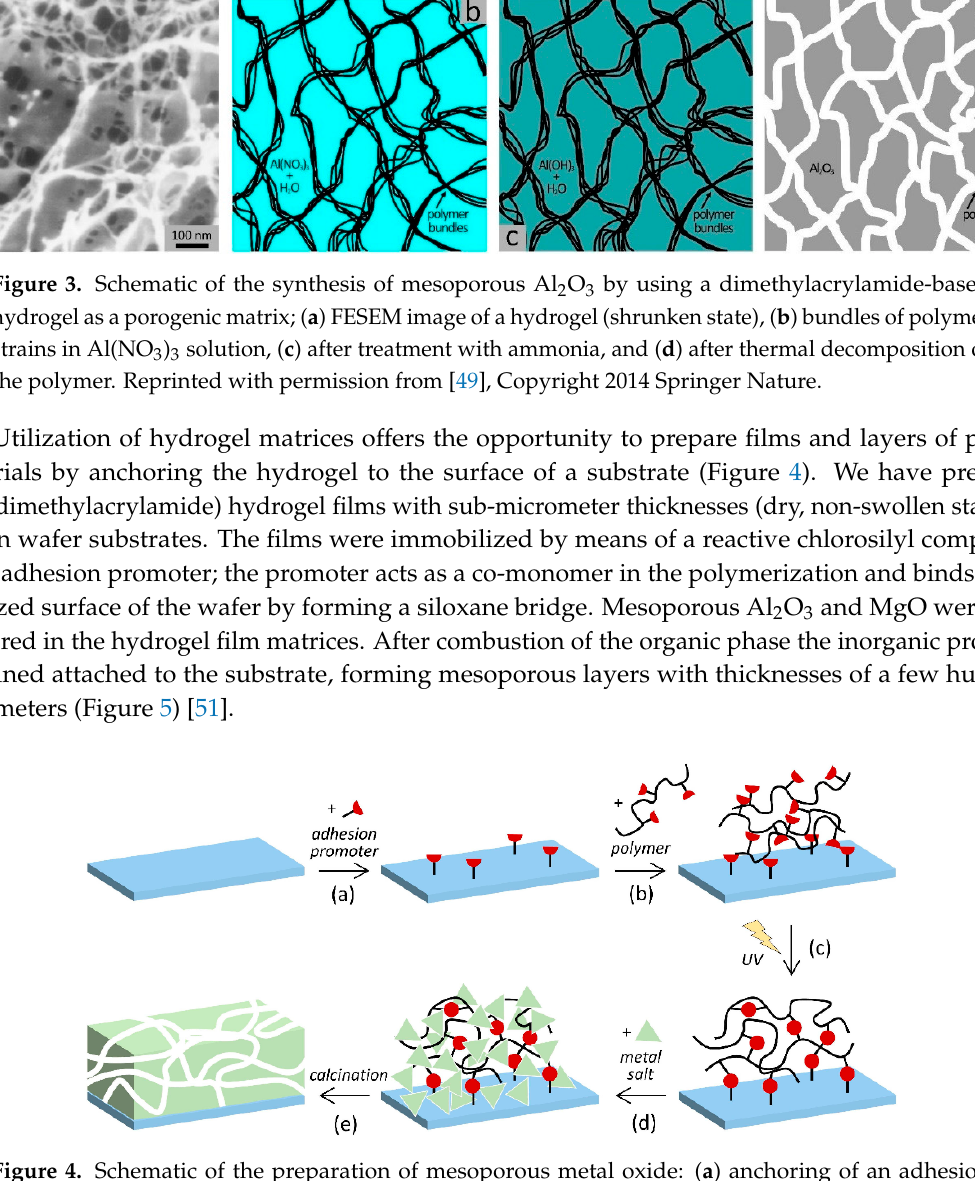
Figure 4. Schematic of the preparation of mesoporous metal oxide: ( a ) anchoring of an adhesion promoter on a substrate; ( b ) spreading of the polymer by spin coating; ( c ) hydrogel formation and immobilization on the substrate by photo-induced cross-linking; ( d ) swelling in metal salt solution; ( e ) formation of the porous metal oxide and combustion of the hydrogel by calcination [51].